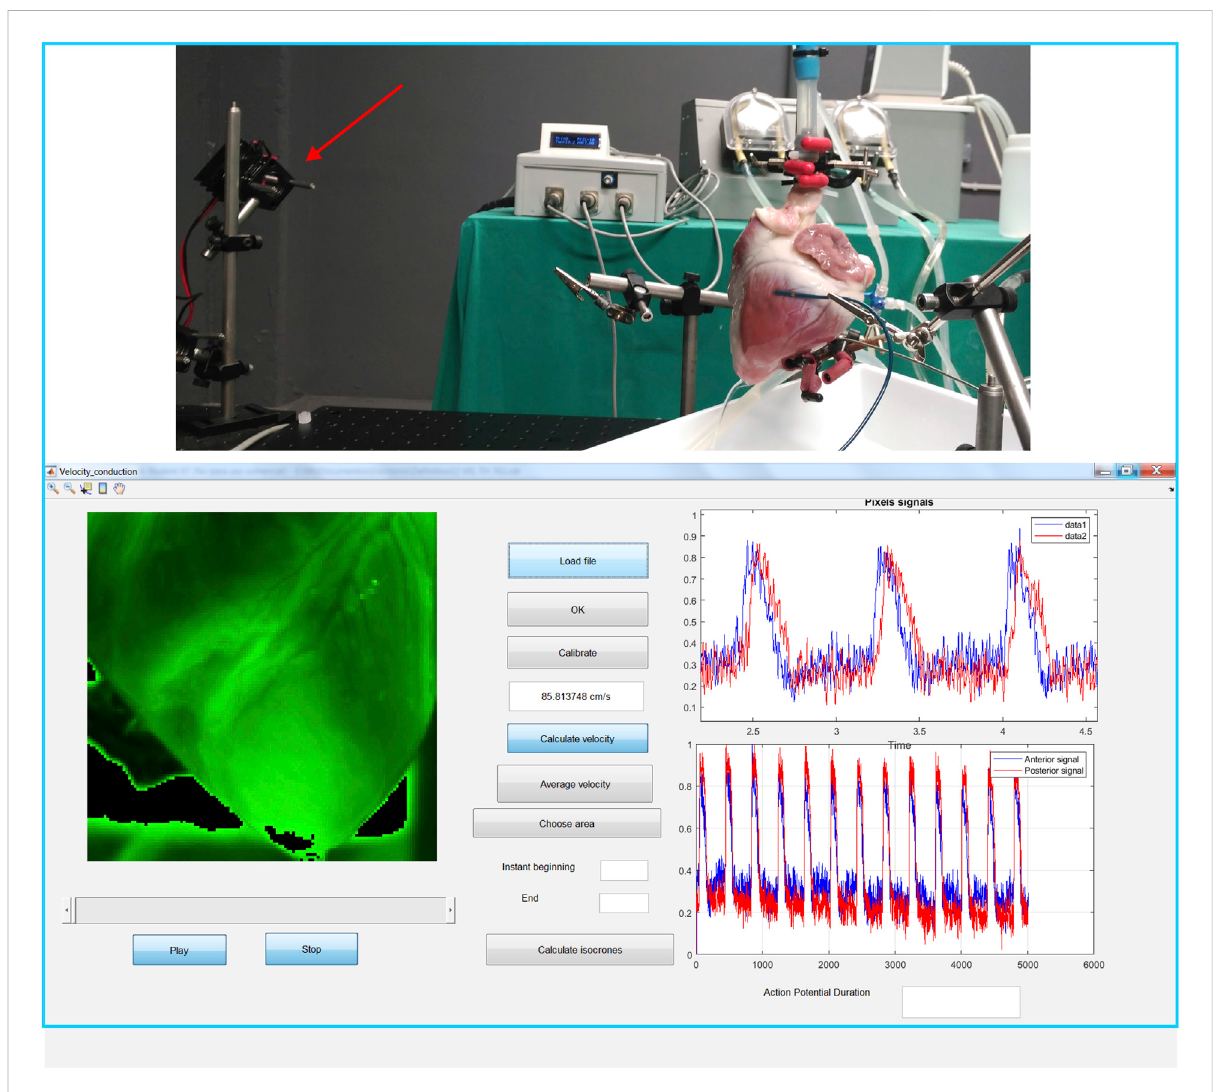
FIGURE 3 Epicardialopticalmapping. Top:thelayout oftheequipment used for optical mapping(the redarrow pointsto thegreenlightsource). Bottom: a screenshot of the software used to perform image